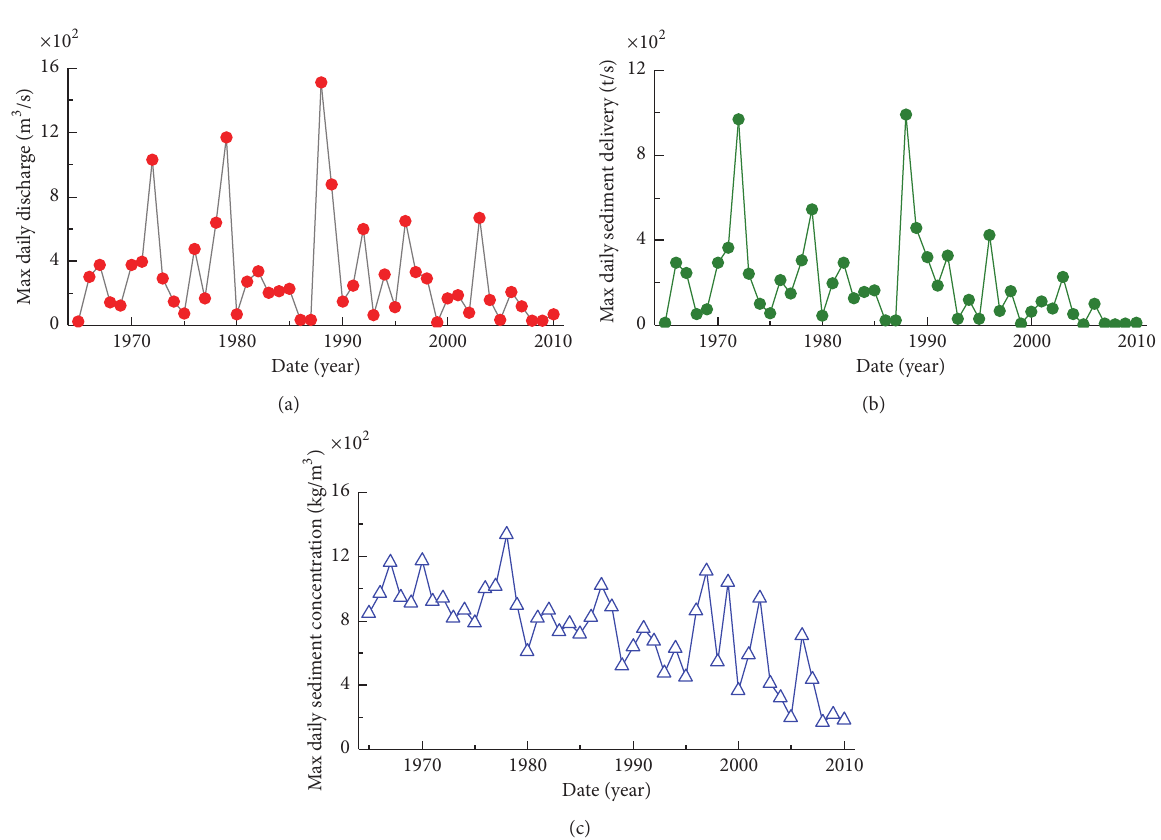
coefficient ( 𝑅 2 ) was of 0.92 between them. Maximum SD